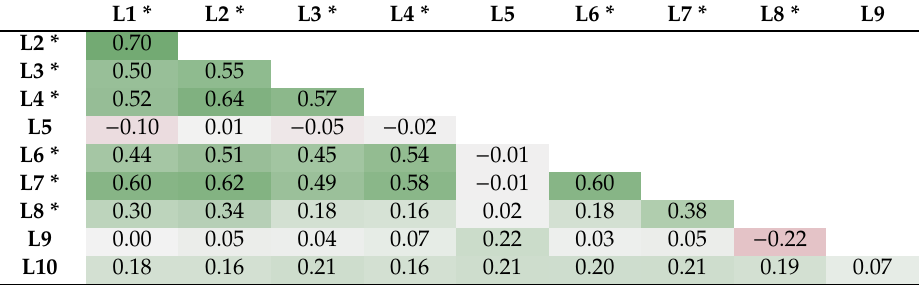
Table 3. Between-item Pearson’s correlation of SAGE WHO Vaccine Hesitancy Scale. Green shades represent positive correlations; red, negative. Upper right cells are blank to eliminate